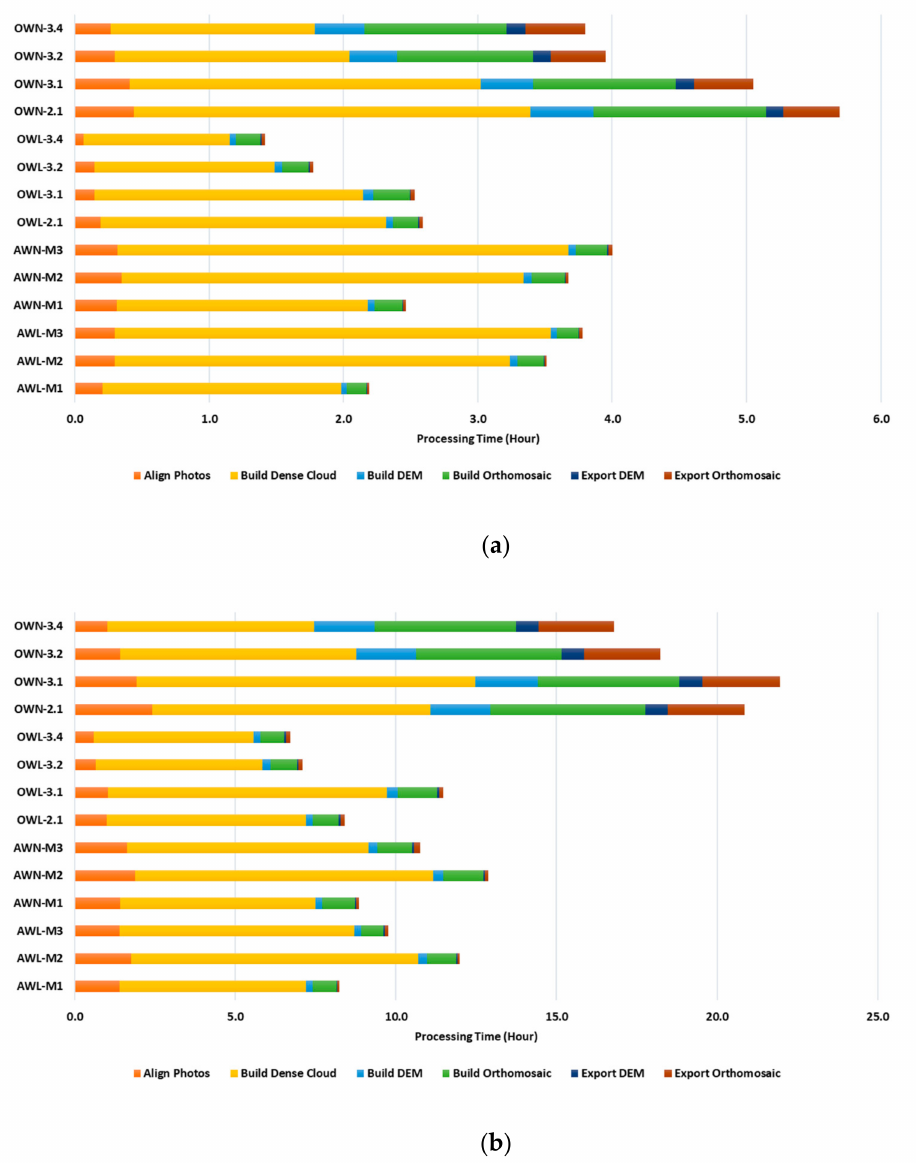
Figure 3. Processing time of SfM procedures using a single-node in the ALC and OCC with different environments for ( a ) small and ( b ) large datasets. Lower is